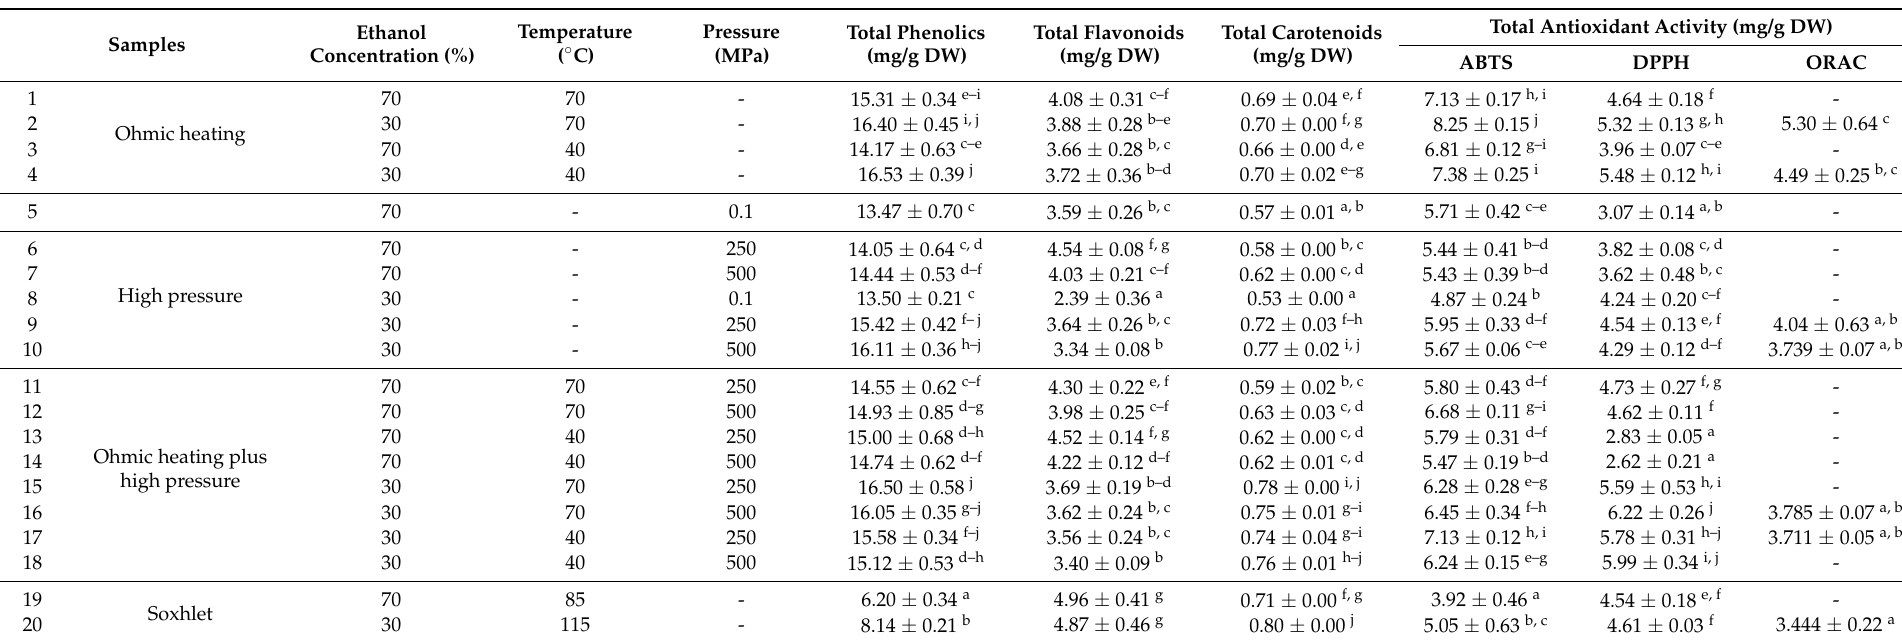
Table 1. Antioxidant activity, total phenolics, total flavonoids, and total carotenoids of extracts obtained under different extraction conditions.